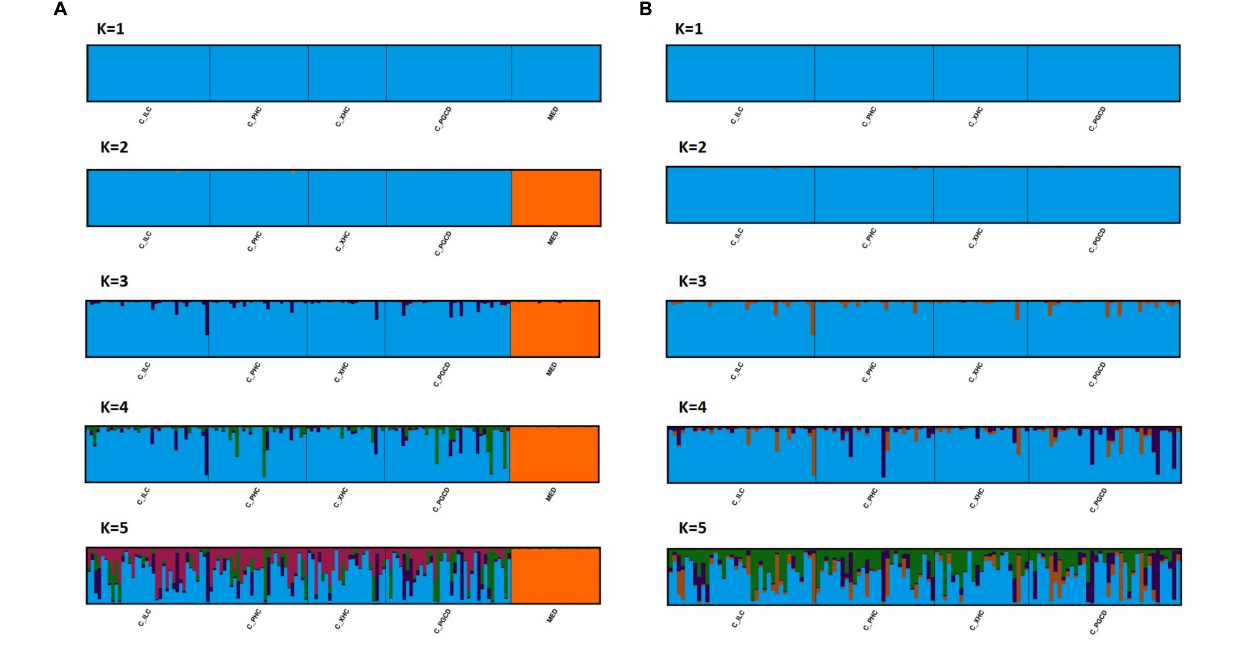
FIGURE 2 | Proportional membership of Desmophyllum dianthus individuals from sequential cluster analyses using STRUCTURE SELECTOR and CLUMPAK, including (A) or excluding (B) individuals from Mediterranean Sea (MED). The clusters ( K = 1–5) are shown with the vertical bars representing each individual broken into colored segments based on the proportion of the genome estimated to have originated from each cluster. For complete locality names (see Figure 1 ). MED stands for Mediterranean Sea, and C_ for